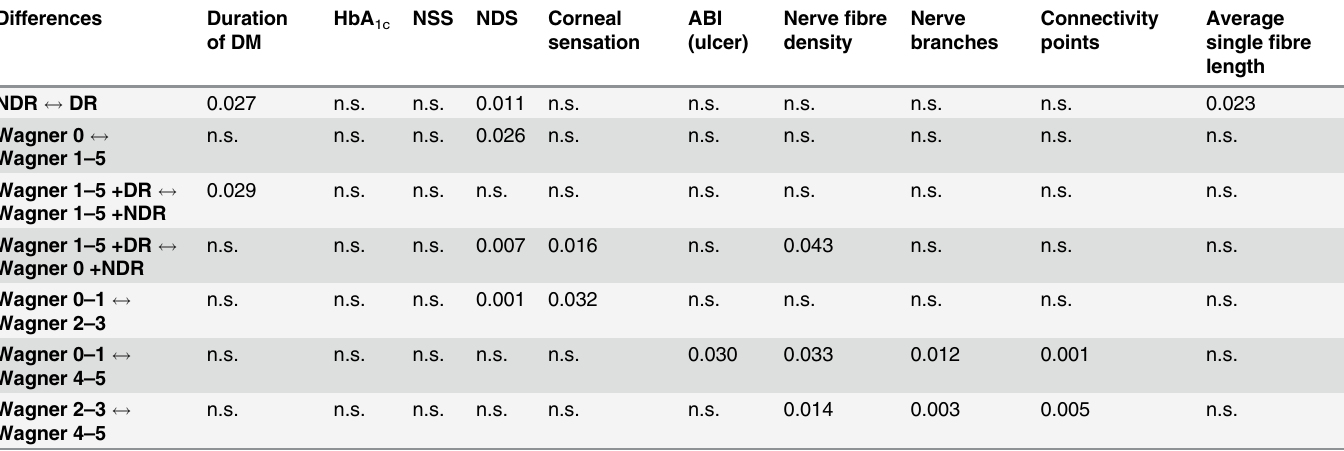
Table 3. Differences between study parameters. Differences